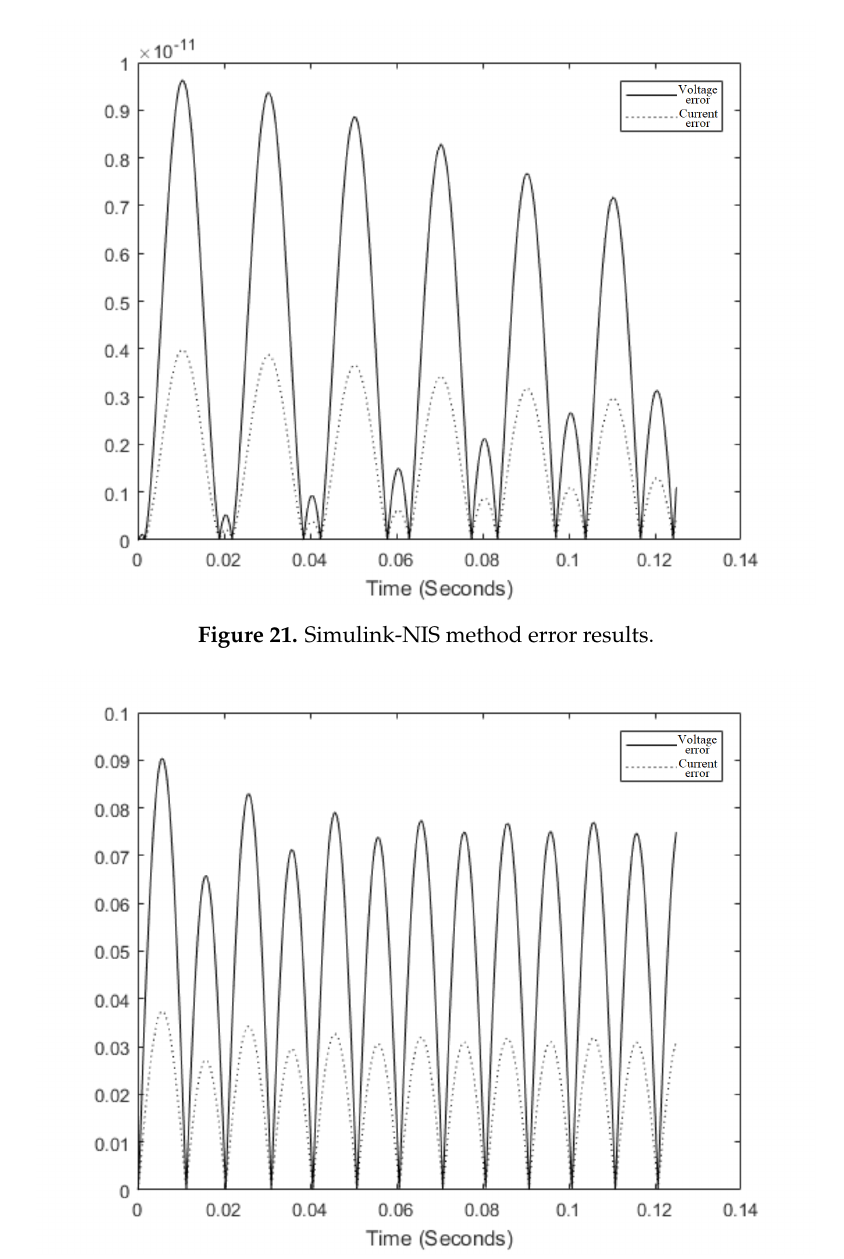
Figure 22. Simulink-hardware error